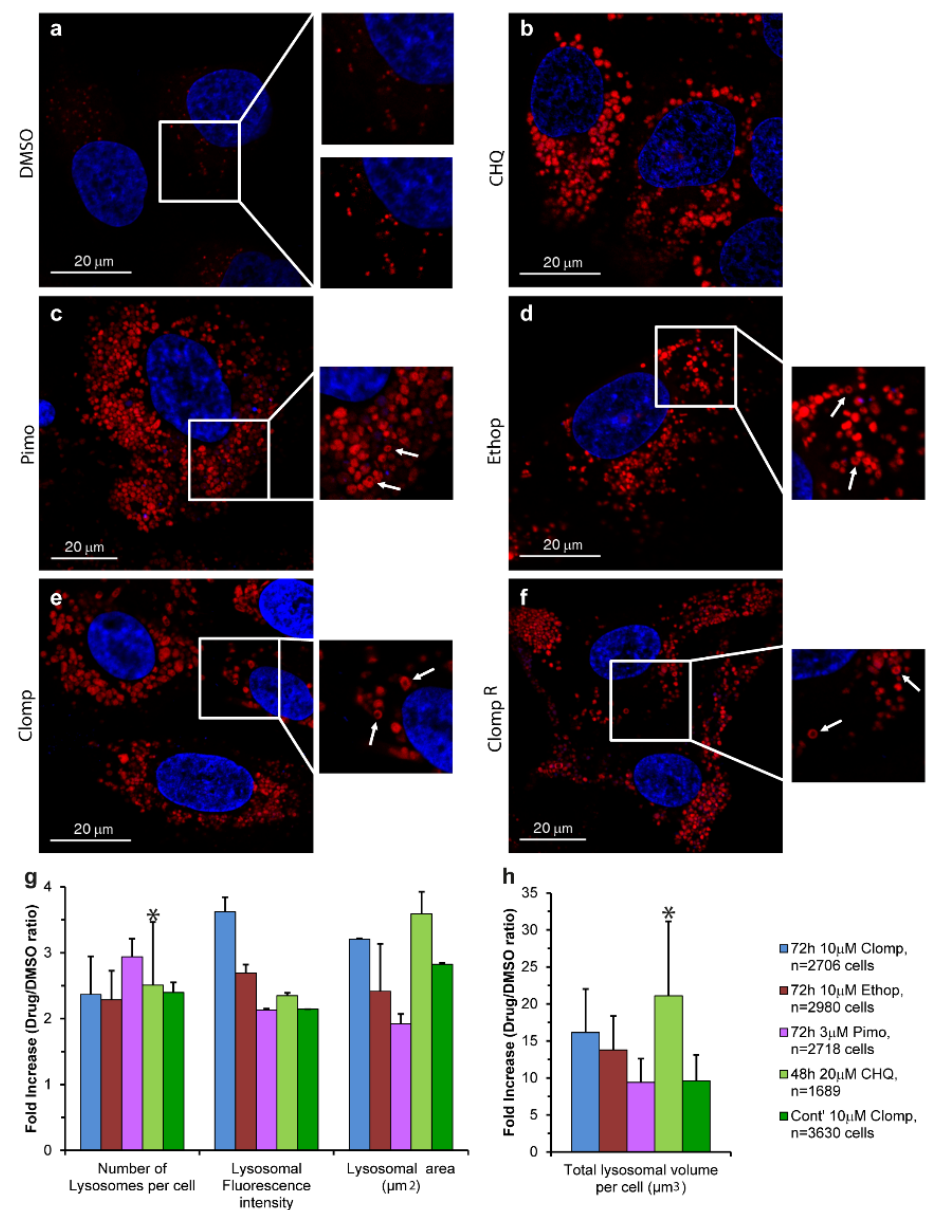
Figure 1. The effect of central nervous system acting drugs (CNSDs) on the number and size of lysosomes. U2OS cells were seeded in black glass bottom plates and treated for 72 h with either 10 µ M Clomp, 10 µ M Ethop, 30 µ M Pimo or 0.1% DMSO for the drug free control. In addition, Clomp R cells continuously grown in 10 µ M Clomp were used, as well as U2OS cells treated for 48 h with 20 µ M CHQ as a positive lysosomotropic control. Nuclei were stained with the viable DNA dye Hoechst 33342 (blue fluorescence), and lysosomes with the lysosomal probe LysoTracker Red DND-99 (LTR) (red fluorescence). ( a – f ): Representative images captured using a confocal Zeiss LSM 710 microscope ( × 63 magnification). Insets: ( a ) show the hardly visible drug free control lysosomes (upper inset) and over-enhanced lysosomes for better visualization (bottom inset), while ( b – f ) show examples of ring-like structures indicated by white arrows. All LTR images are representative of data collected from at least three independent experiments. ( g , h ) Cells were captured using an InCell Analyzer 2000 fluorescence microscope, and lysosomes were analyzed using the InCell Investigator software. Histograms depict the average median values obtained from three independent experiments ± S.D. All p values < 0.045 except for the ones indicated by an asterisk. See also Figure S3.